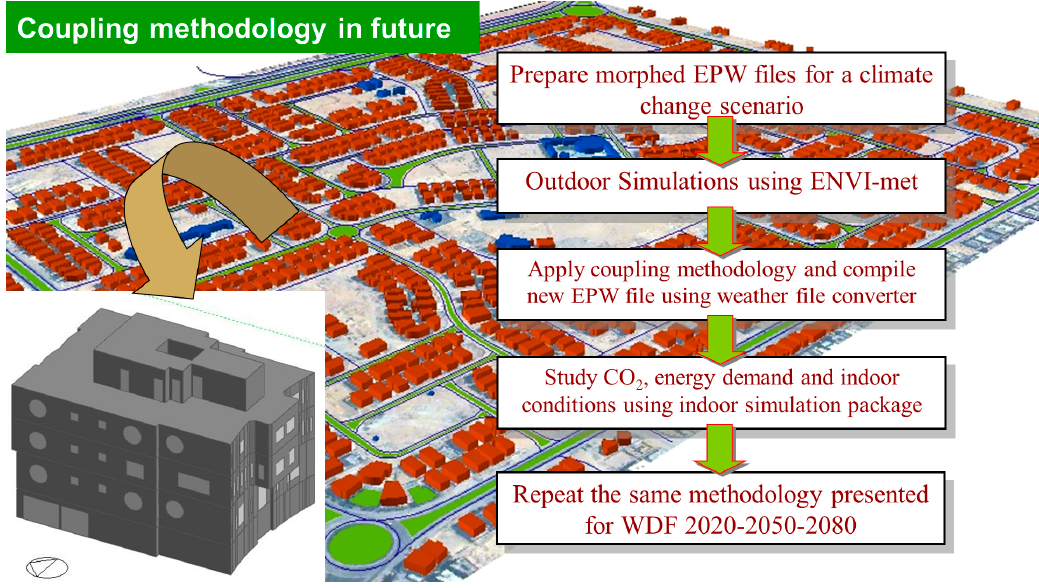
Figure 6. The coupled simulation methodology in present and future as a baseline for ERA Tripling Evaluation Methodology, TEM, modified after [38] .